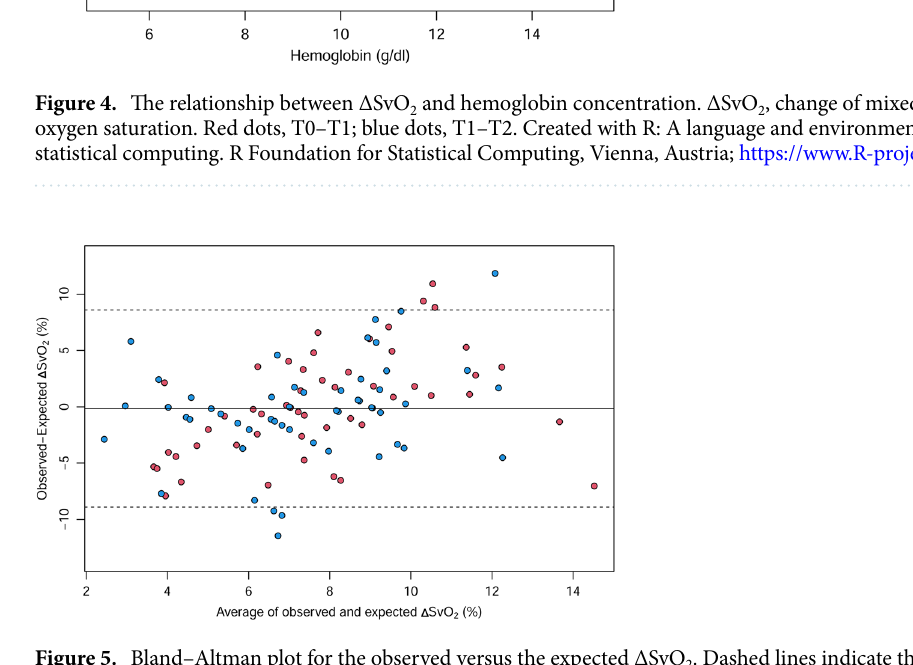
Figure 5. Bland–Altman plot for the observed versus the expected ΔSvO 2 . Dashed lines indicate the limits of agreement (the mean ± 1.96 × the standard deviation of the residual ΔSvO 2 ). ΔSvO 2 , change of mixed venous oxygen saturation. Red points, T0–T1; blue points, T1–T2. Created with R: A language and environment for statistical computing. R Foundation for Statistical Computing, Vienna, Austria; https:// www.R- proje ct.